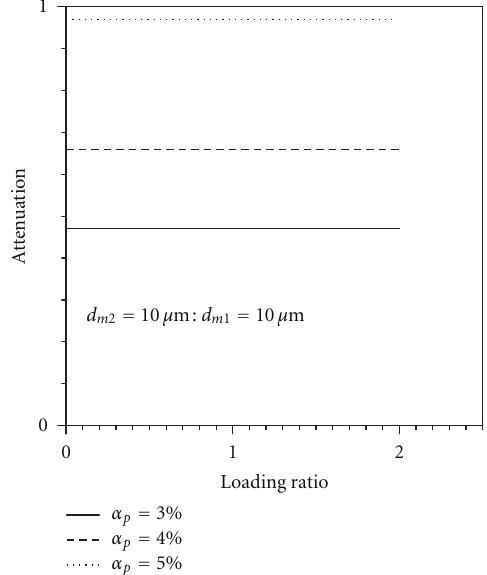
Figure 12: Nondimensional attenuation as function of particle diameter and loading distribution [ α p 2 : α p 1 ] for two sets of particles (10 μ m [ d m 1 ] and 10 μ m [ d m 2 ] particles), reference motor, acceleration nullified.